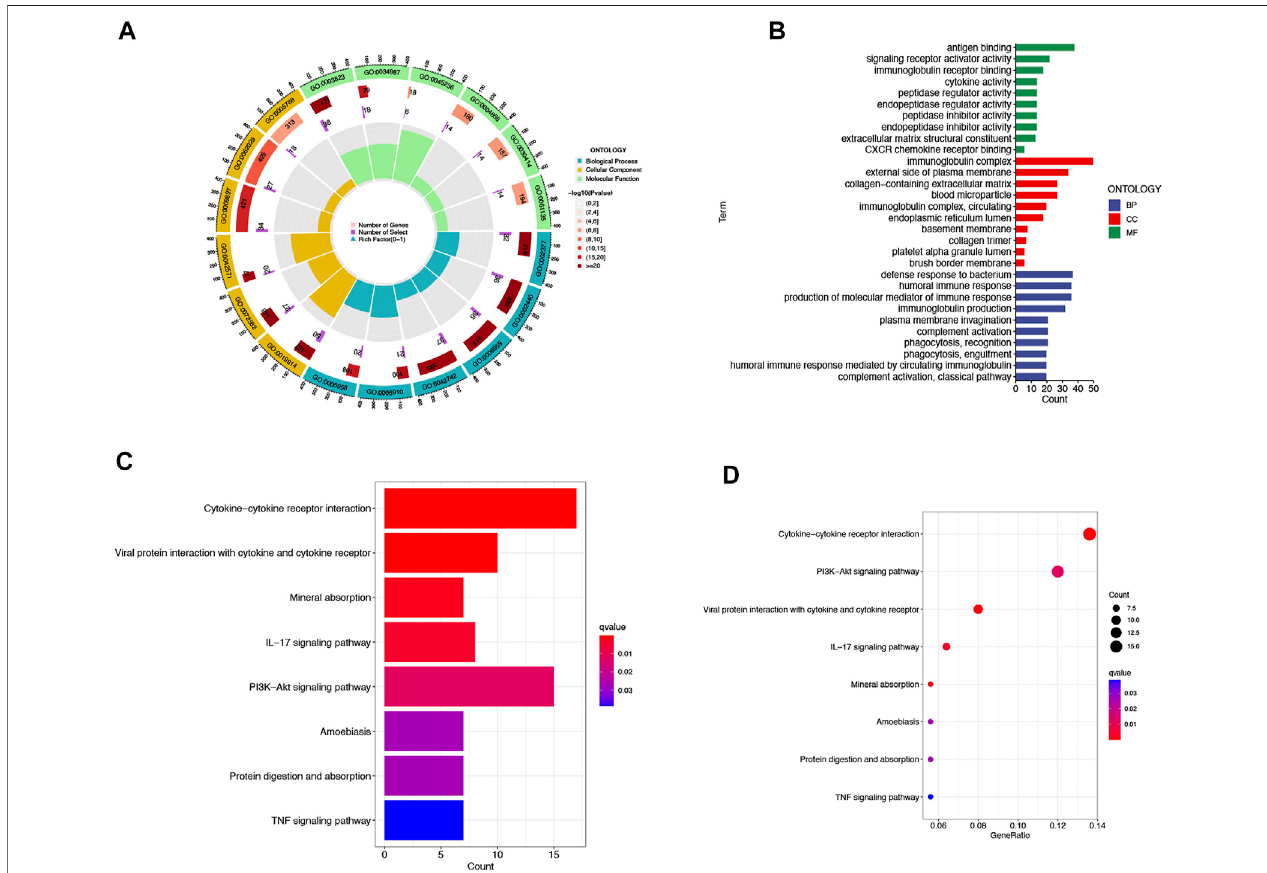
FIGURE 7 | GO and KEGG analysis. Gene Ontology (GO) analysis demonstrated the richness of molecular biological processes (BP), cellular components (CC), and molecular functions (MF) (A , B) . KEGG pathway analysis showed the signi fi cantly enriched pathways (C , D) .